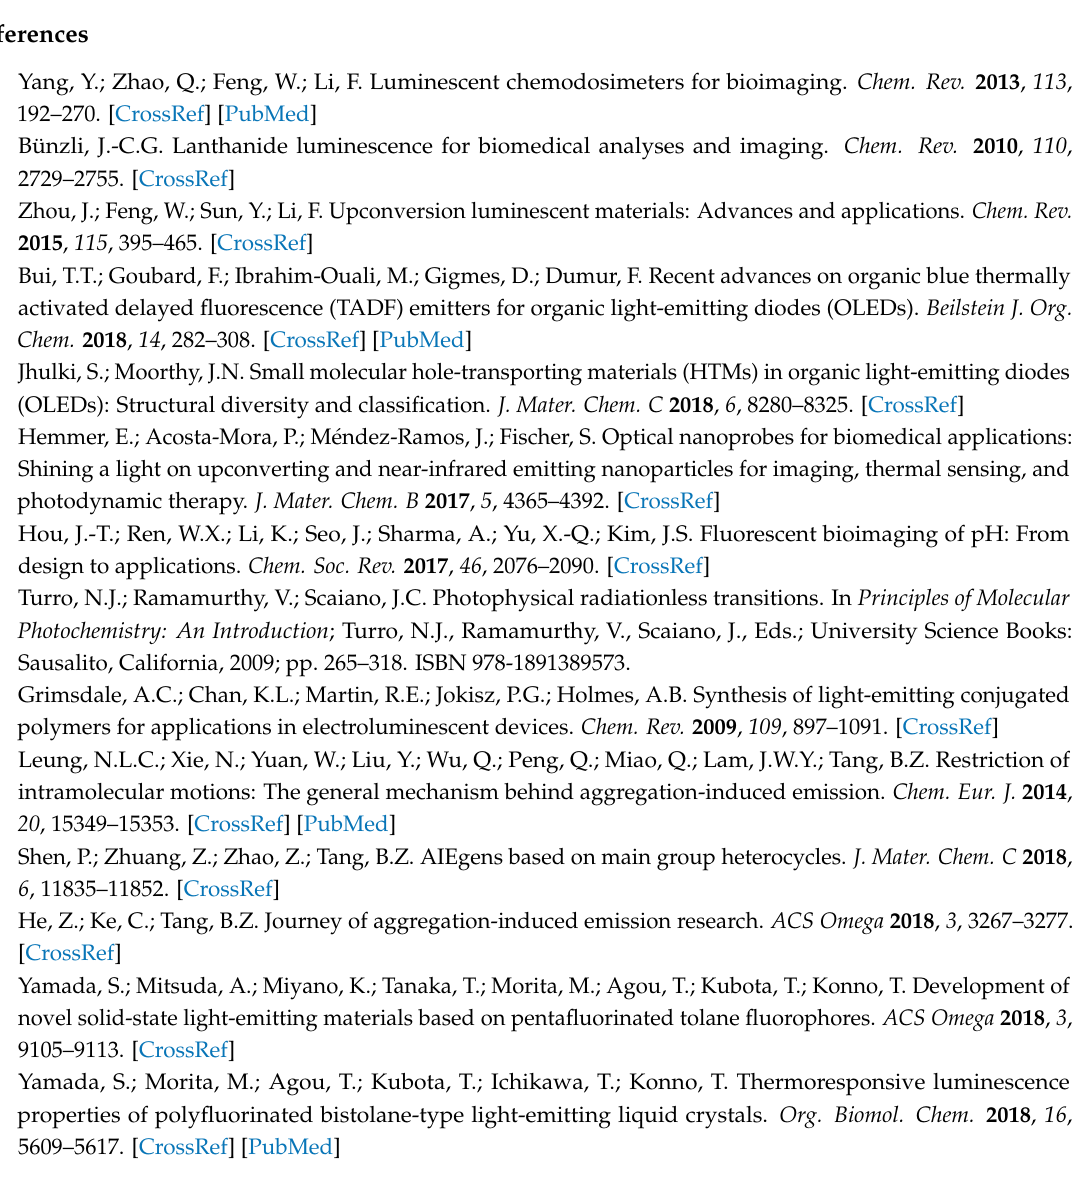
Figure S1: Crystal packing structures, Table S1: Crystallographic data, Figure S2: DSC thermograms, Figure S3: Absorption and PL spectra, Figure S4: Excitation and PL spectra, Figure S5: Molecular orbital diagrams for S -2a obtained after DFT calculation, Table S2: Cartesian coordinates for S -2a , Figure S6: Molecular orbital diagrams for R -2a obtained after DFT calculation, Table S3: Cartesian coordinates for R -2a , Figure S7: Molecular orbital diagrams for S -2b obtained after DFT calculation, Table S4: Cartesian coordinates for S -2b